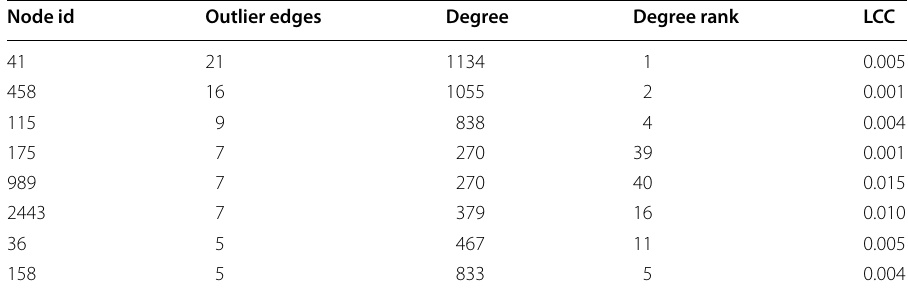
Table 8 Outlier node detection results on Brightkite